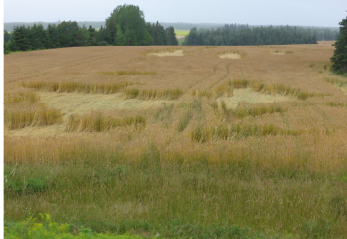
Figure 2. Sample ground image of a barley field with lodging damage from Flight1